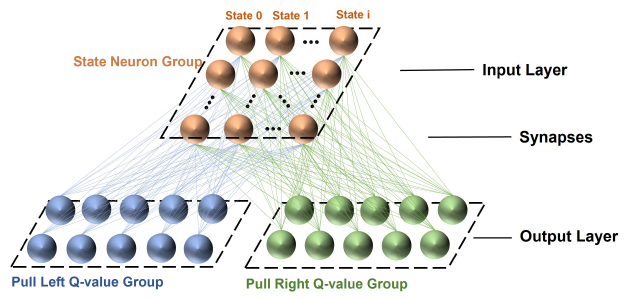
Figure 2. The overall structure of the SNN using